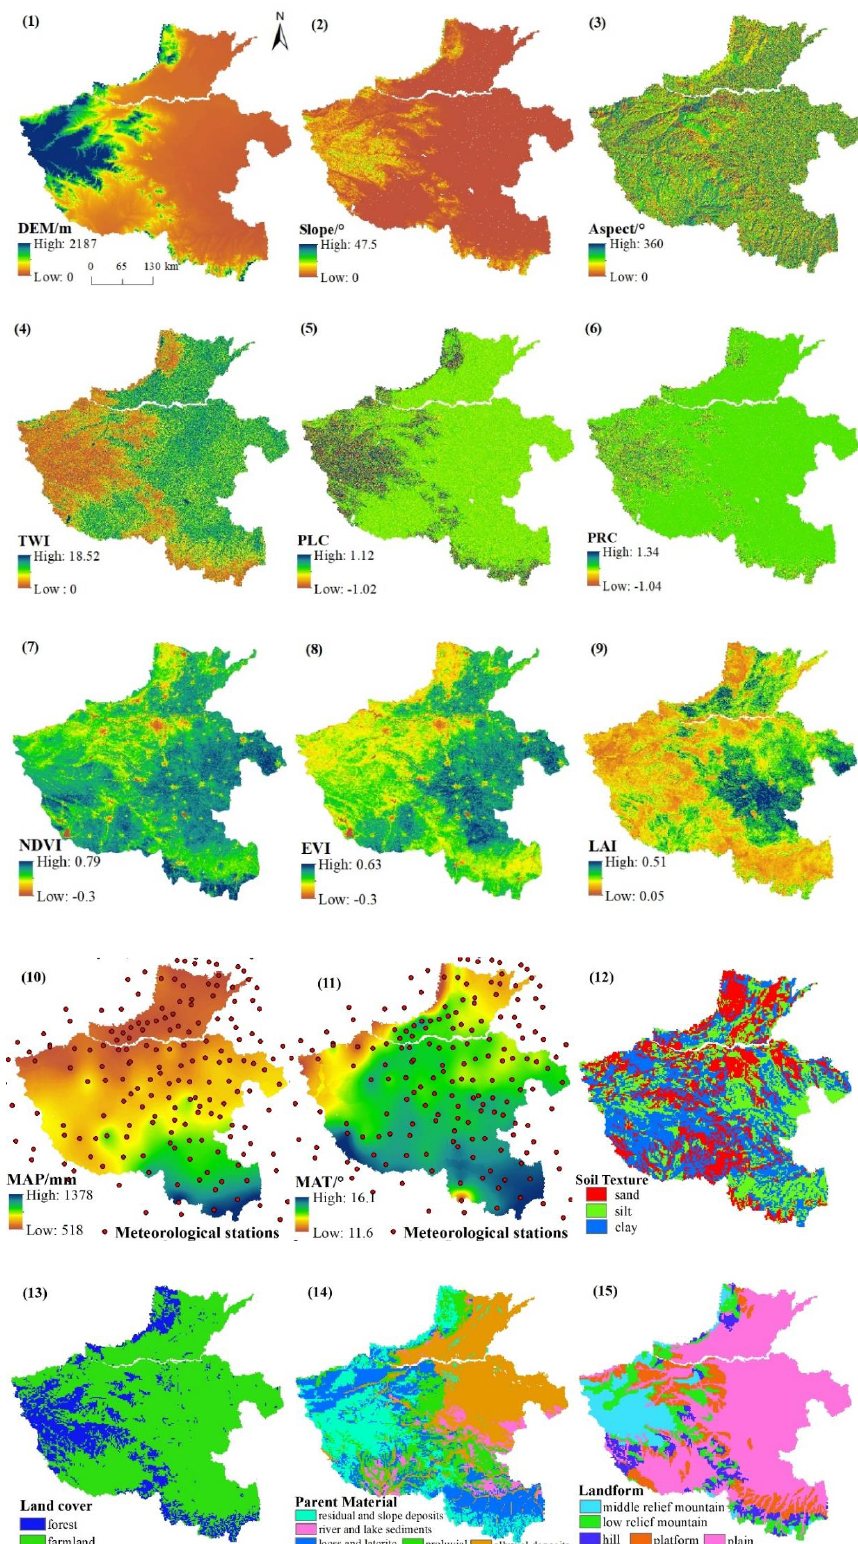
Figure 2. Spatial distributions of 15 environmental variables in the study area.